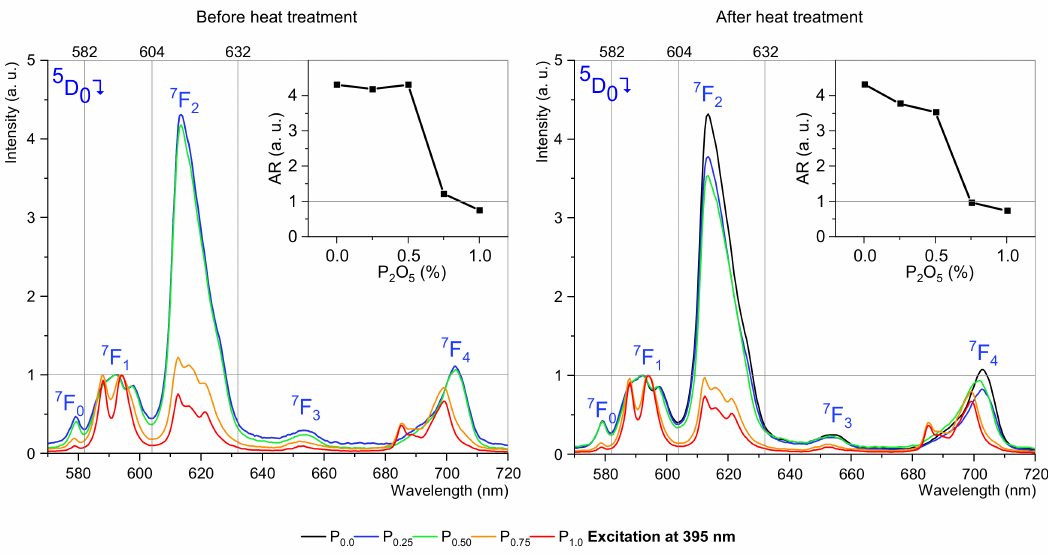
Figure 4. Luminescence spectra of SGS glasses doped with 0.5 mol%. In insets, asymmetry ratios are as a function of P 2 O 5